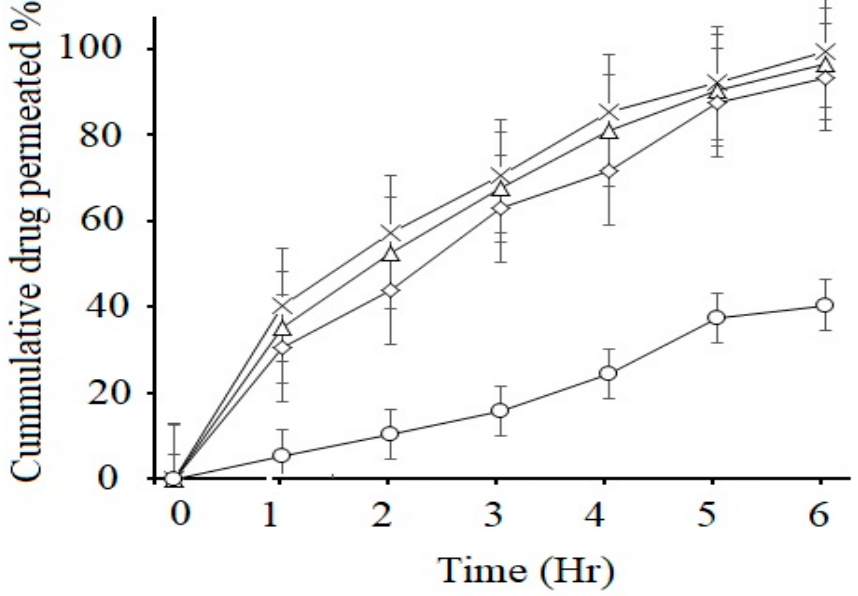
) and CFX from oily droplets (cid:35)